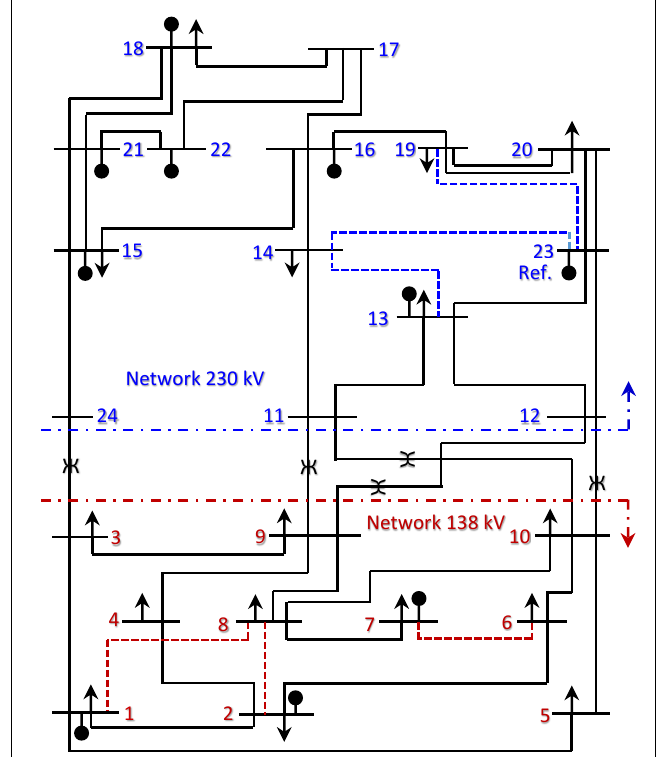
Figure 4: IEEE-24/41 test system